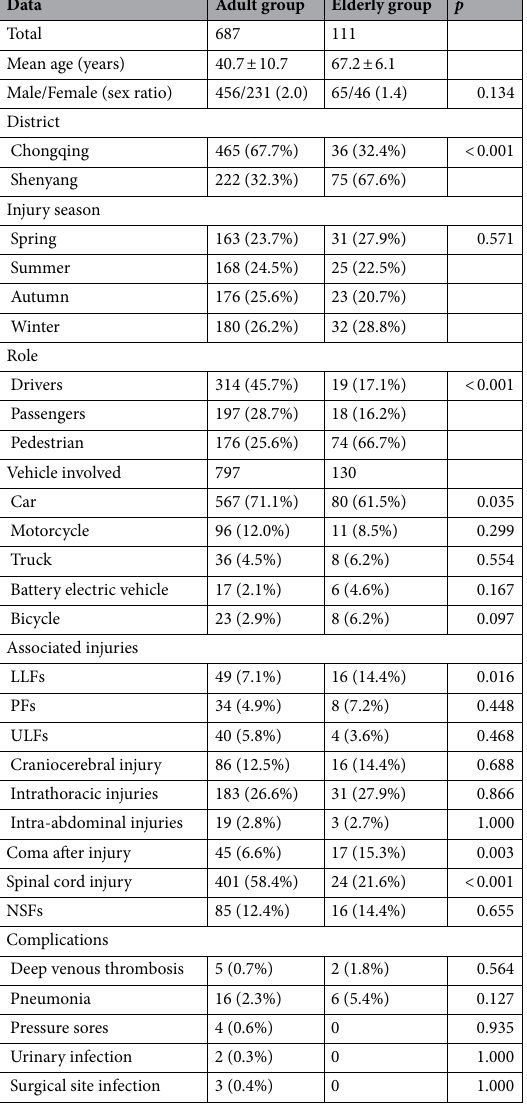
Table 2. Age differences in TSFs caused by